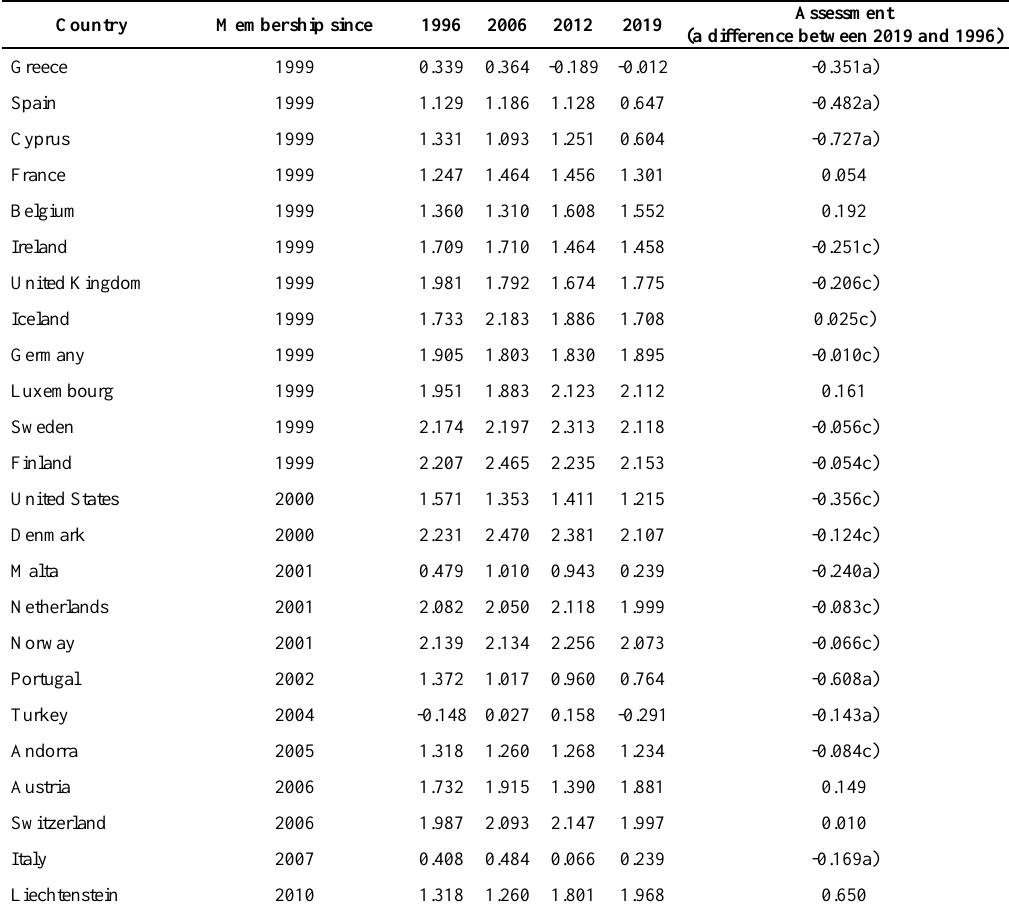
Table 2. The performance score in the Control of Corruption (Worldwide Governance Indicators), the GRECO group West,